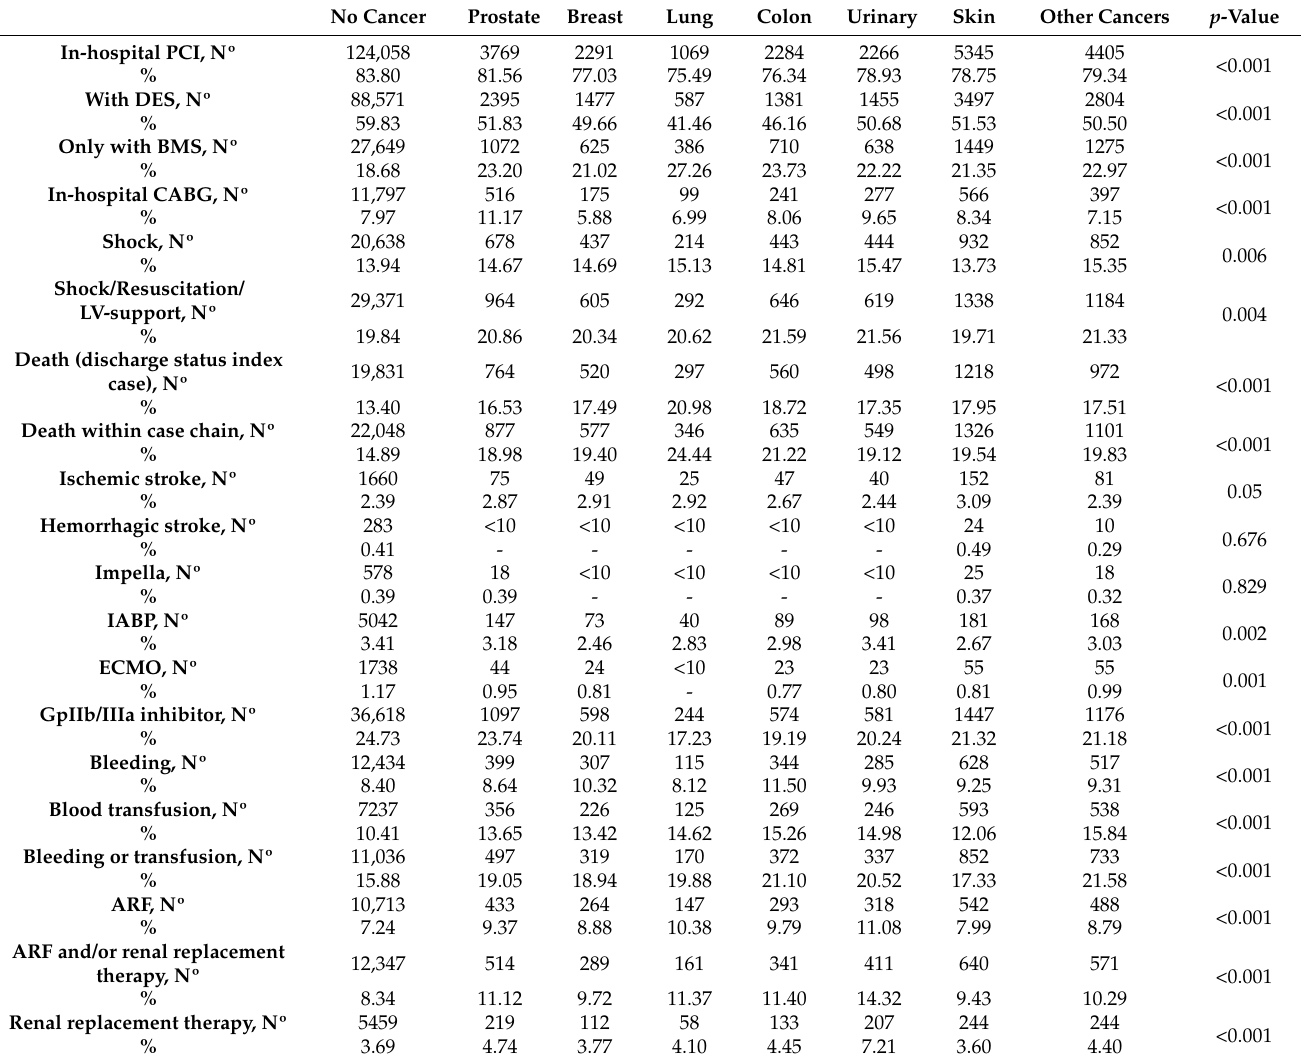
Table 2. In-hospital treatment and outcomes of STEMI patients with malignancies. No Cancer Prostate Breast Lung Colon Urinary Skin Other Cancers p